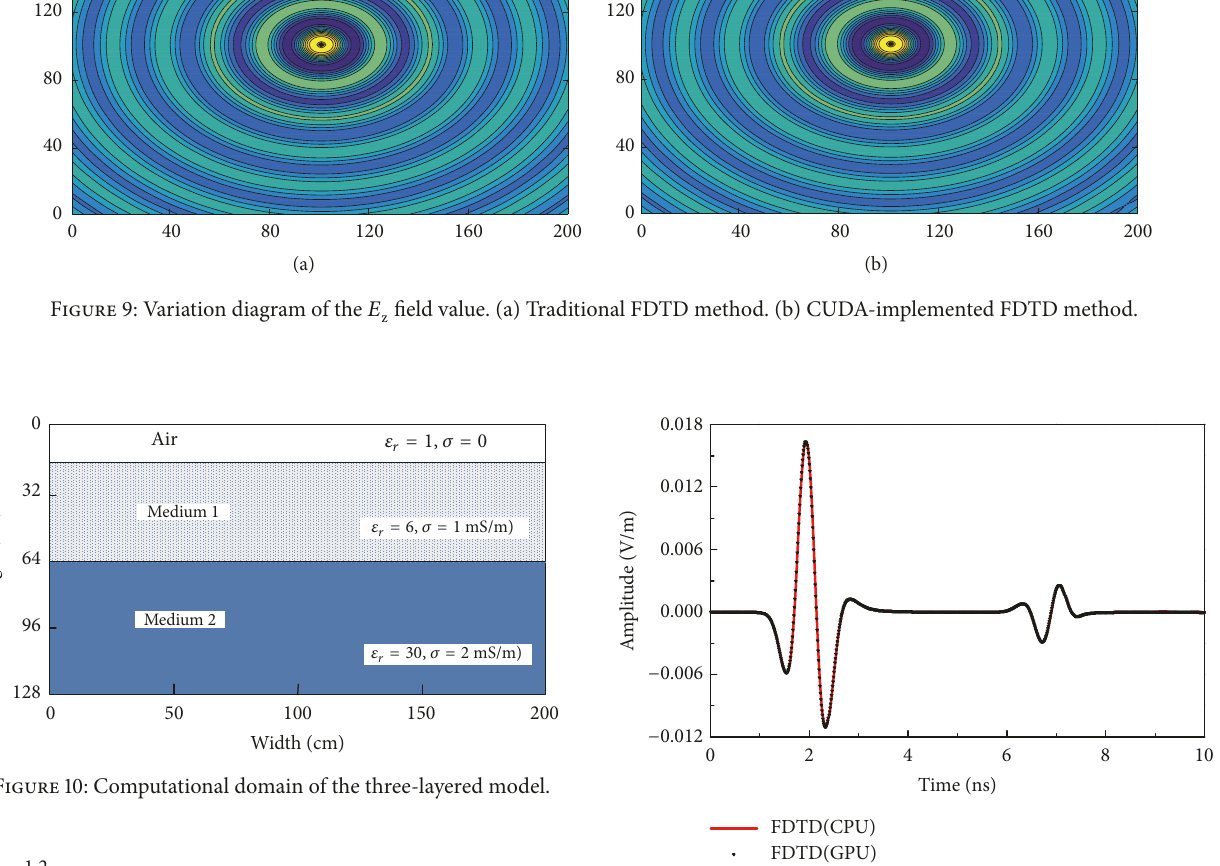
Figure 12: Map of the single-track radar data calculated using two